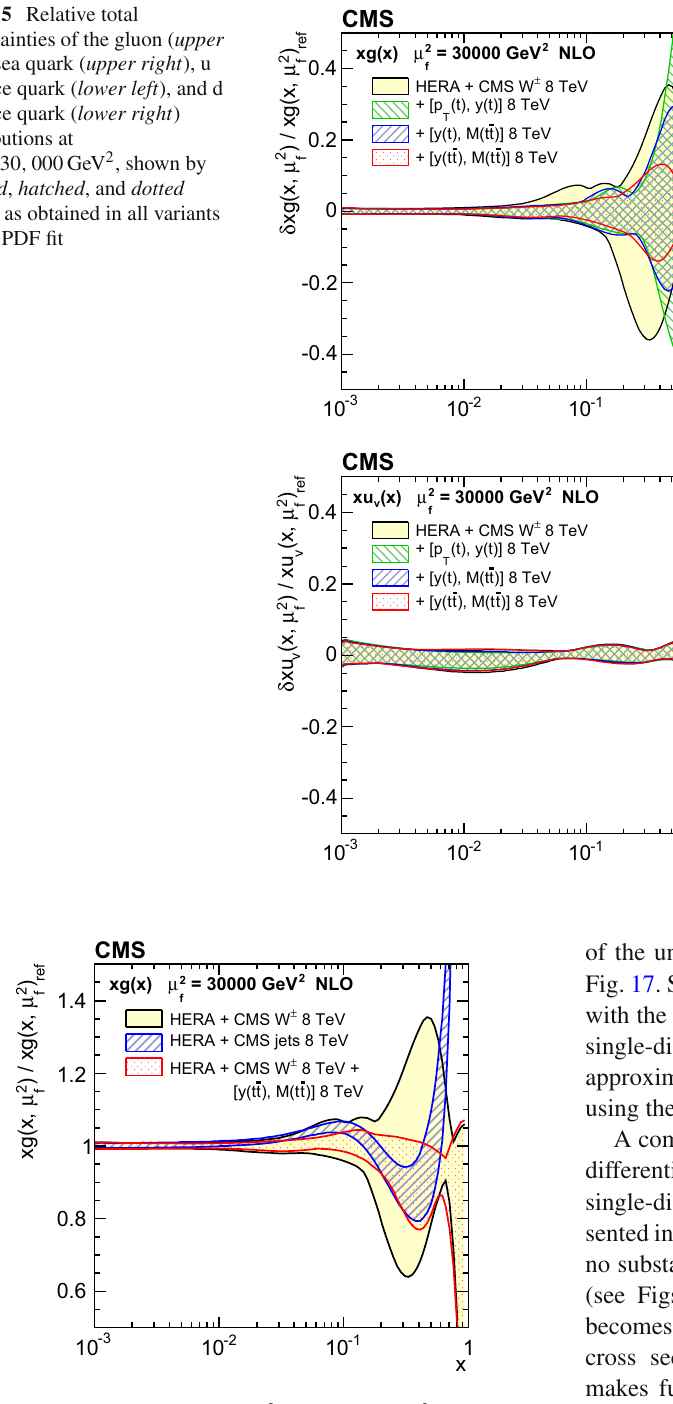
= 30 , 000GeV 2 , as obtained Fig. 16 The gluon distribution at μ 2 f from the PDF fit to the HERA DIS data and CMS W ± boson charge asymmetrymeasurements( shadedarea ),theCMSinclusivejetproduc- tioncrosssections( hatchedarea ),andtheW ± bosonchargeasymmetry plus the double-differential tt cross section ( dotted area ). All presented PDFs are normalized to the results from the fit using the DIS and W ± boson charge asymmetry measurements. The shaded , hatched , and dot- ted areas represent the total uncertainty in each of the